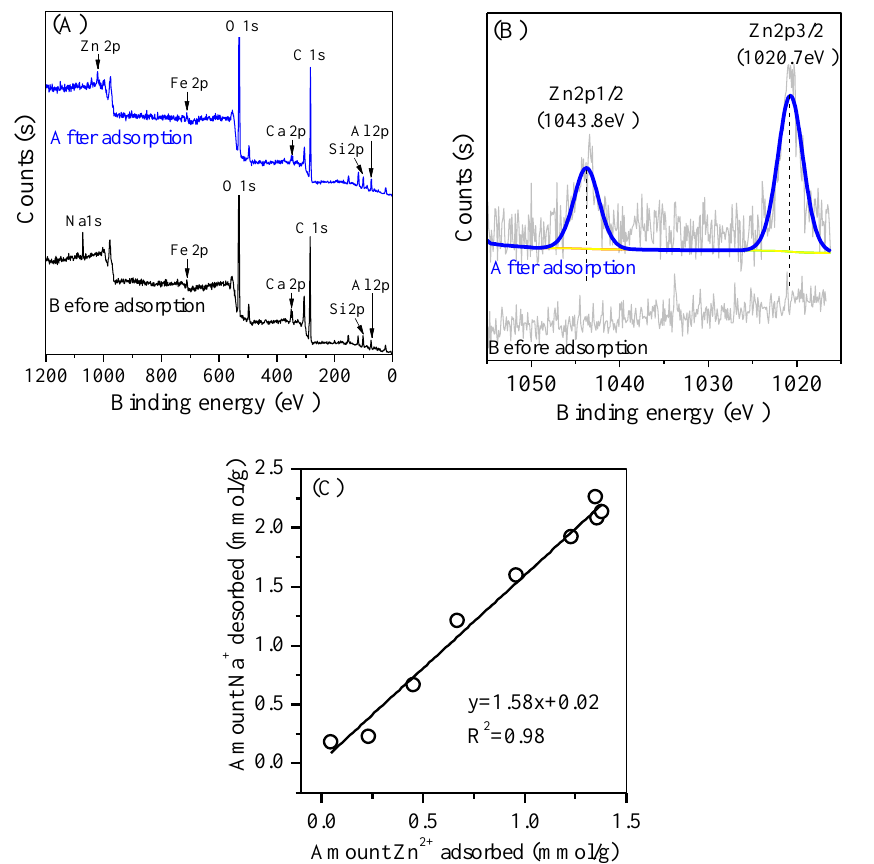
Figure 9. ( A ) Full range and ( B ) Zn 2p XPS spectra of P-200 before and after Zn 2+ adsorption, and ( C ) amount of Na + desorbed as affected by Zn 2+ adsorption on P-200. Experimental conditions: equilibrium time: 12 h, P-200 dosage: 0.01 g, initial pH: 4.